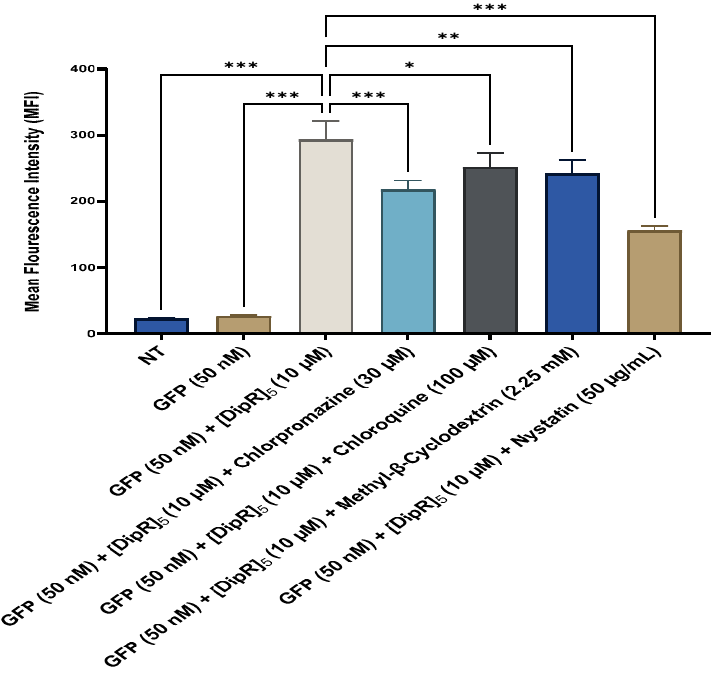
Figure 19. Cellular uptake of the GFP-[DipR] 5 mixture at a peptide concentration (10 µ M) and GFP at (50 nM) for 3 h in MDA-MB-231 cells studied by flow cytometry. The results are mean ± SD ( n = 3) (ns; no signi (cid:281) cance, * p < 0.05, ** p < 0.01, *** p < 0.001; treatments vs. control (GFP alone).